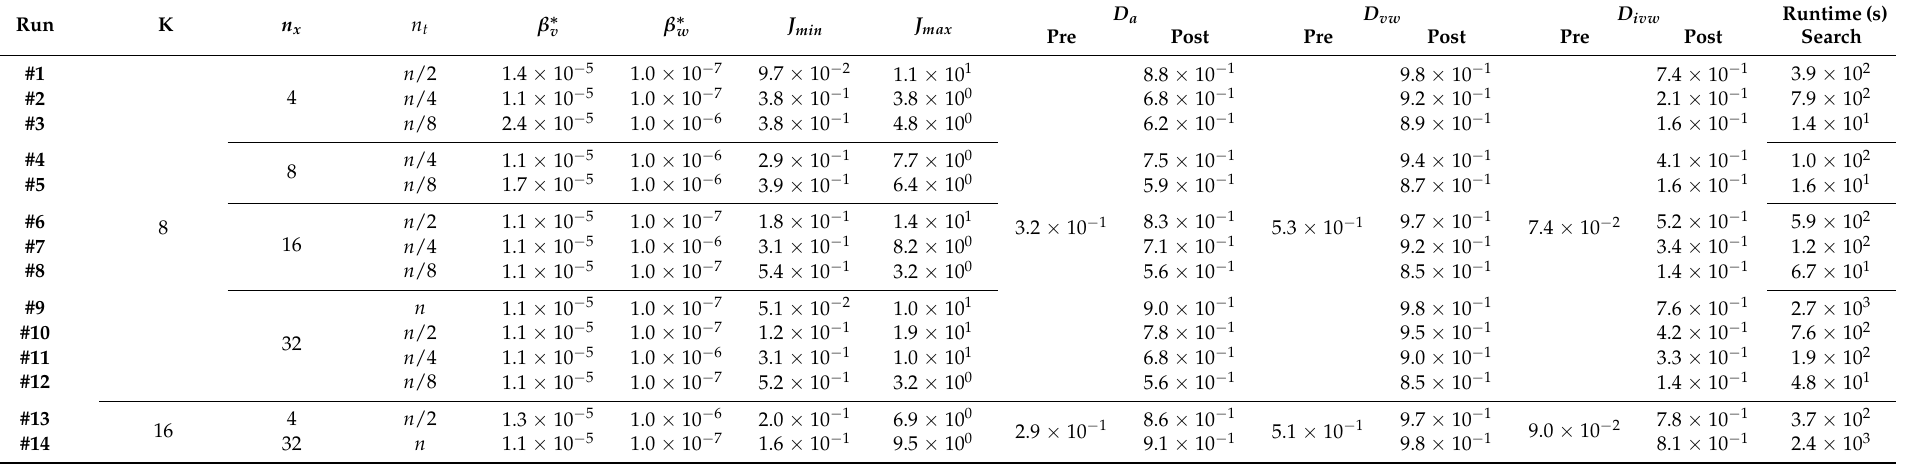
Table 6. Experiment 2A: Registration performance for CLAIRE for case 2 ( n t independent of the image resolution). Comparison of registration accuracy using Dice at different resolutions for the synthetic dataset SYN. K denotes the frequency of the synthetic velocity field in Equation (12). n = ( 1024,1024,1024 ) is the base image resolution. We fix the tolerance for the reduction of the gradient to 5 × 10 − 2 and use linear interpolation. The Jacobian bounds for parameter search is ∗ [ 0.05,20 ] . For each value of n t , we report results for different resolutions. We report β ∗ v and β w (the optimal regularization parameters obtained with the proposed parameter search scheme), and J min and J max (the minimum and maximum values for the determinant of the deformation gradient). For the Dice score, we report average Dice ( D a ), the volume weighted average Dice ( D vw ), and the inverse volume weighted average Dice ( D ivw ), pre and post the registration. We also report the wall clock time for the parameter search. The missing cases for K = 8 failed to finish in a reasonable time frame. We only report a couple of cases for K = 16 and expect a behavior similar to K = 8 for the